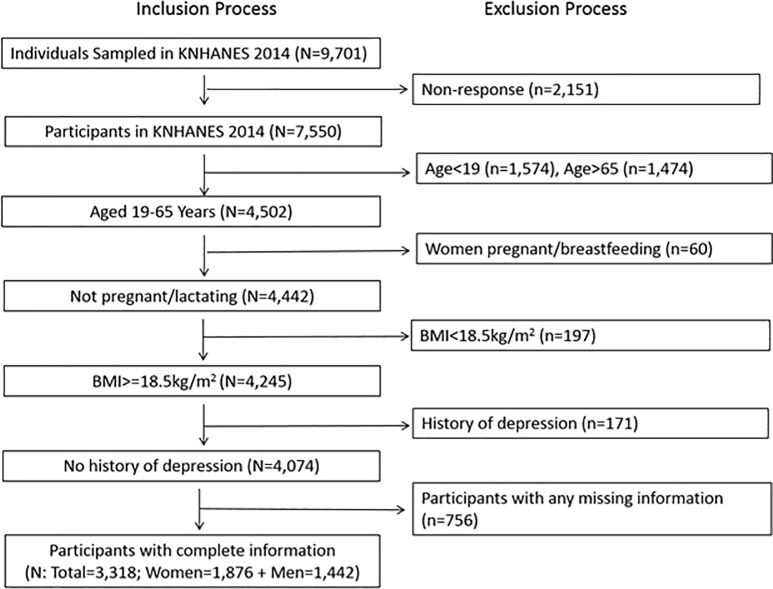
Inclusion and exclusion processes for the analytic sample from the Korea National Health and Nutrition Examination Survey (KNHANES) in 2014.